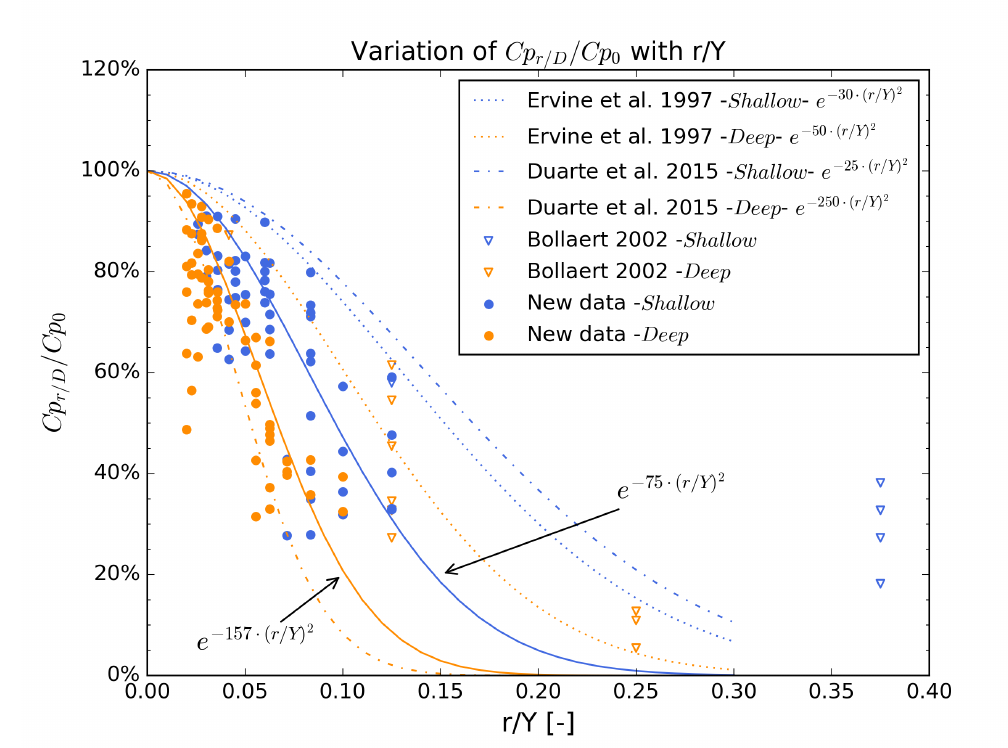
Figure 6. Variation of Cp r / D with r / Y out from jet centreline—difference made between shallow and Cp 0 deep